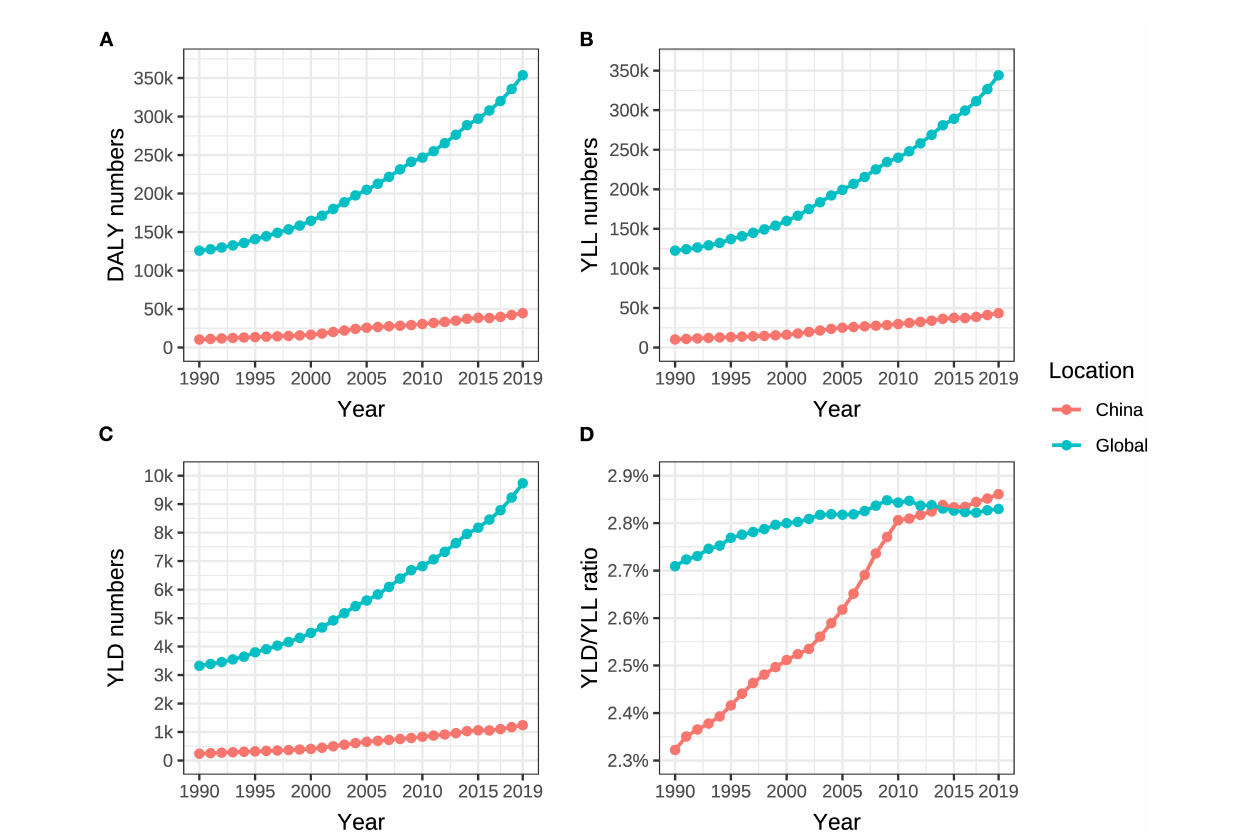
FIGURE4 DALY, YLL, YLD of ovarian cancer, and YLD/YLL ratio attributable to hyperglycemia from 1990 to 2019. (A) DALY numbers, (B) YLL numbers, (C) YLD numbers, and (D) YLD/YLL ratio.